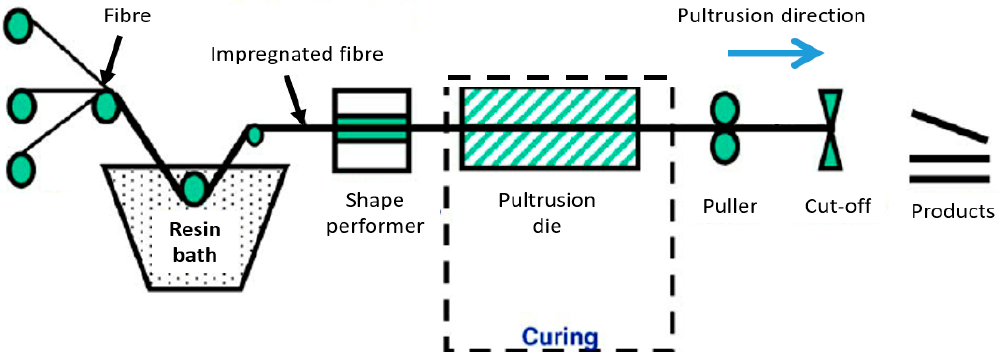
Figure 4. Schematic diagram of pultrusion process of pultruded composite [57].